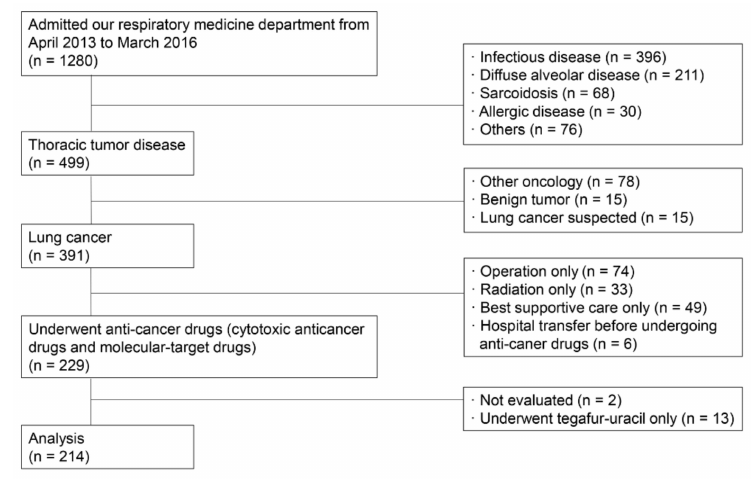
Figure 2. Study flow diagram. Table 1. Characteristics of lung cancer patients who underwent anti-cancer